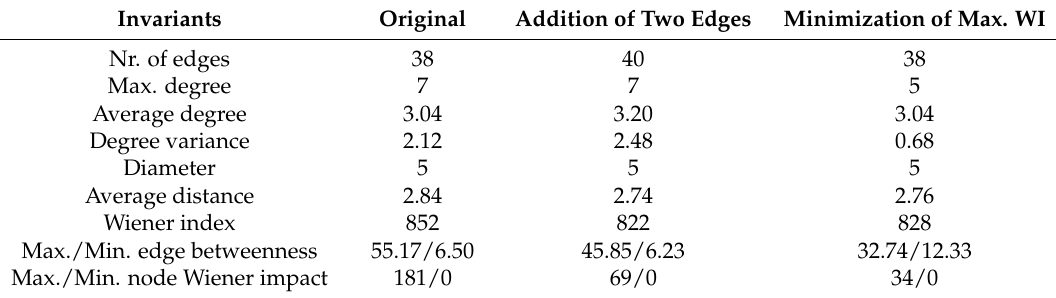
Figure 5. RNP backbone: resultant 2-connected graph with 25 nodes. Table 5. RNP backbone (25